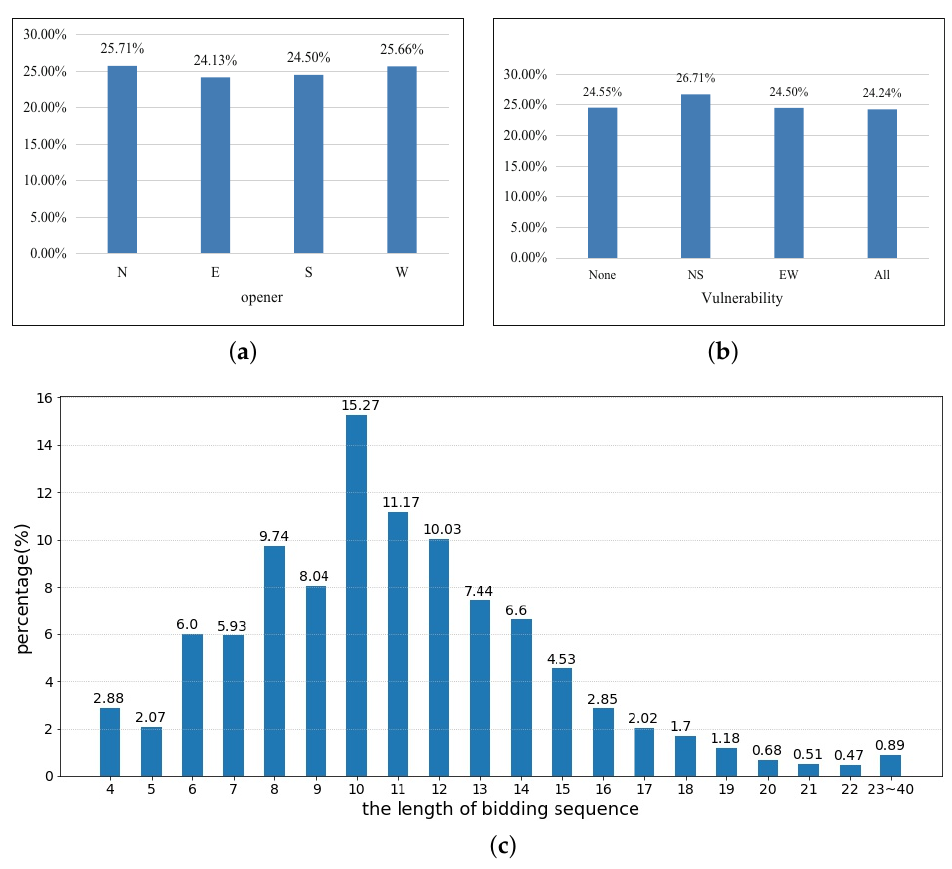
Figure 9. Dataset Evaluation. ( a ) The distribution of opener in dataset. ( b ) The distribution of vulnerability in dataset. ( c ) The distribution of lengths of bidding sequences in the